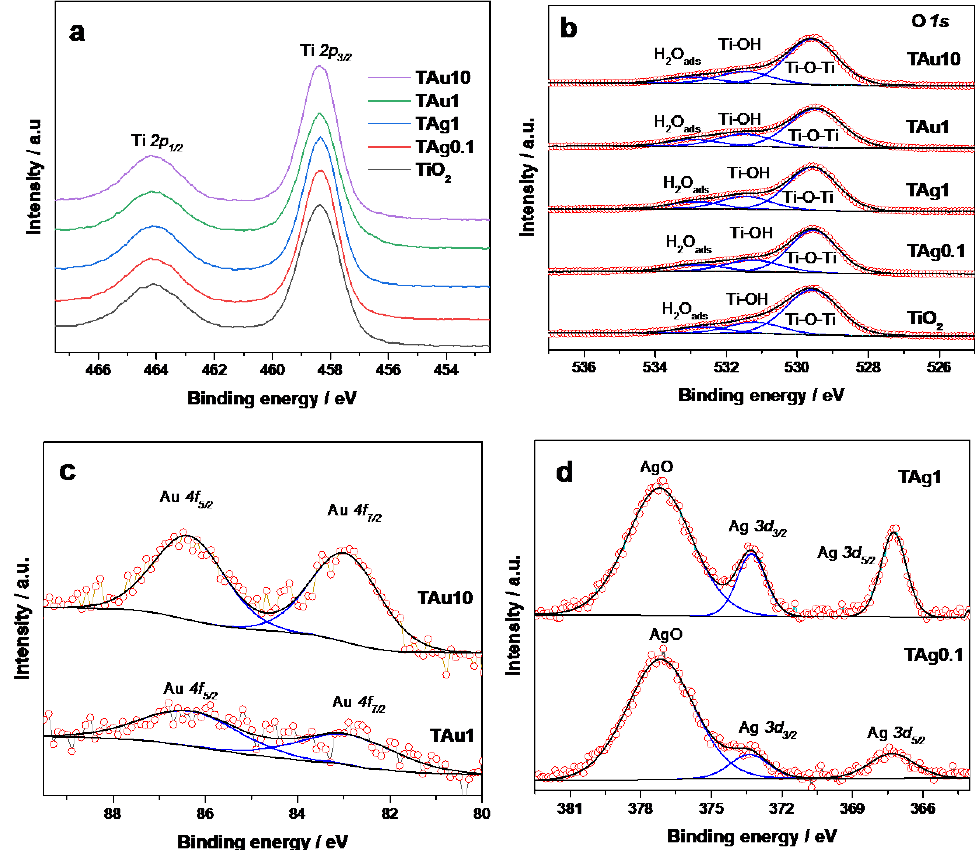
Figure 11. XPS spectra results of ( a ) Ti 2p zone of all samples; ( b ) O 1s zone of all samples; ( c ) Au 4f zone of TAu1 and TAu10 samples; and ( d ) Ag 3d zone of TAg0.1 and TAg1 samples.